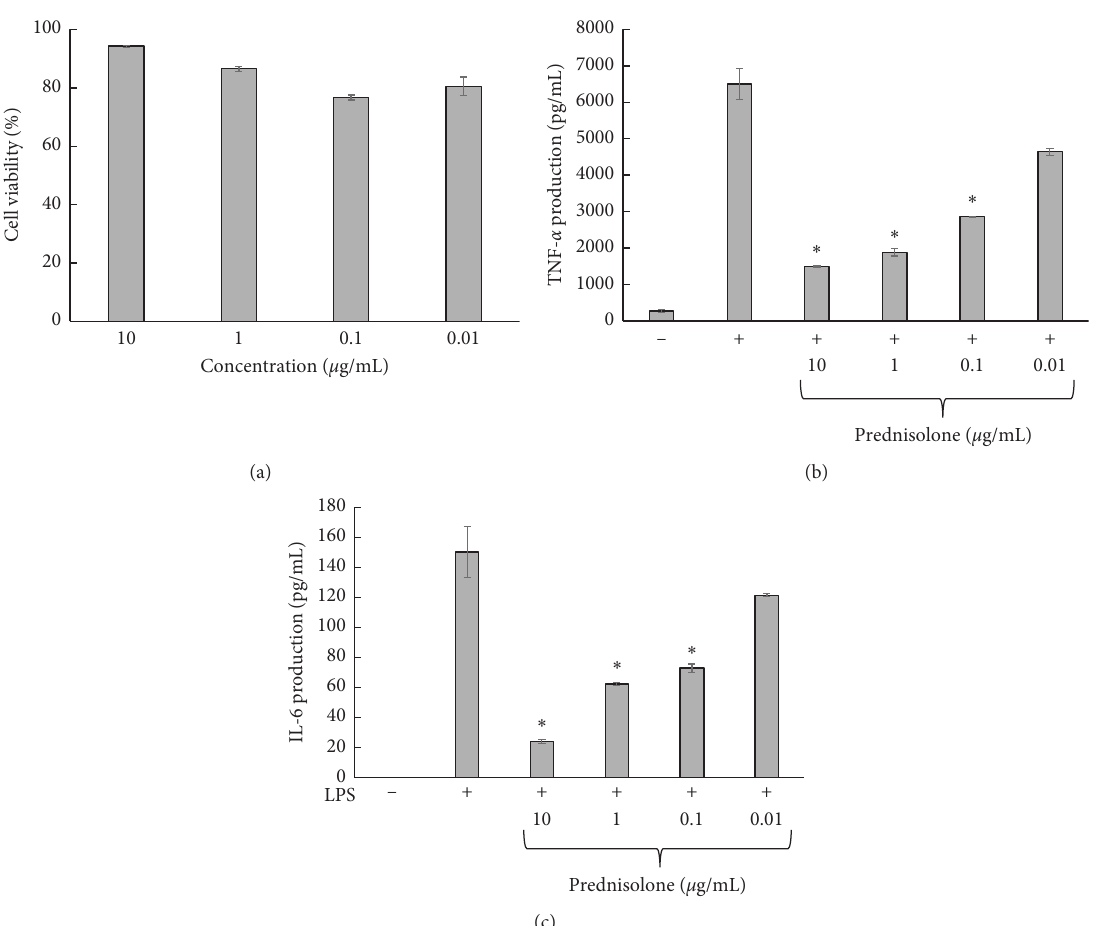
Figure 3: Effect of prednisolone on RAW264.7 cell viability (a), TNF- α production (b), and IL-6 production (c). ∗ p < 0 . 05 when compared with LPS-stimulated